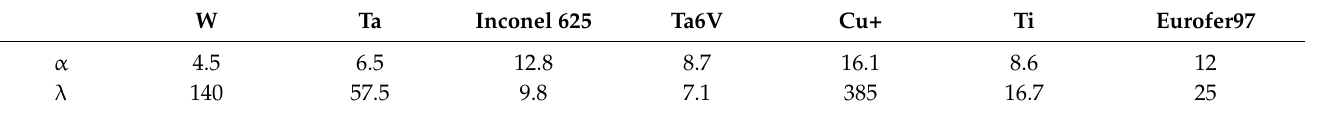
Table 1. Coefficient of thermal expansion ( α /10 − 6 · K − 1 ) and thermal conductivity ( λ /W · m − 1 · K − 1 ), measured at